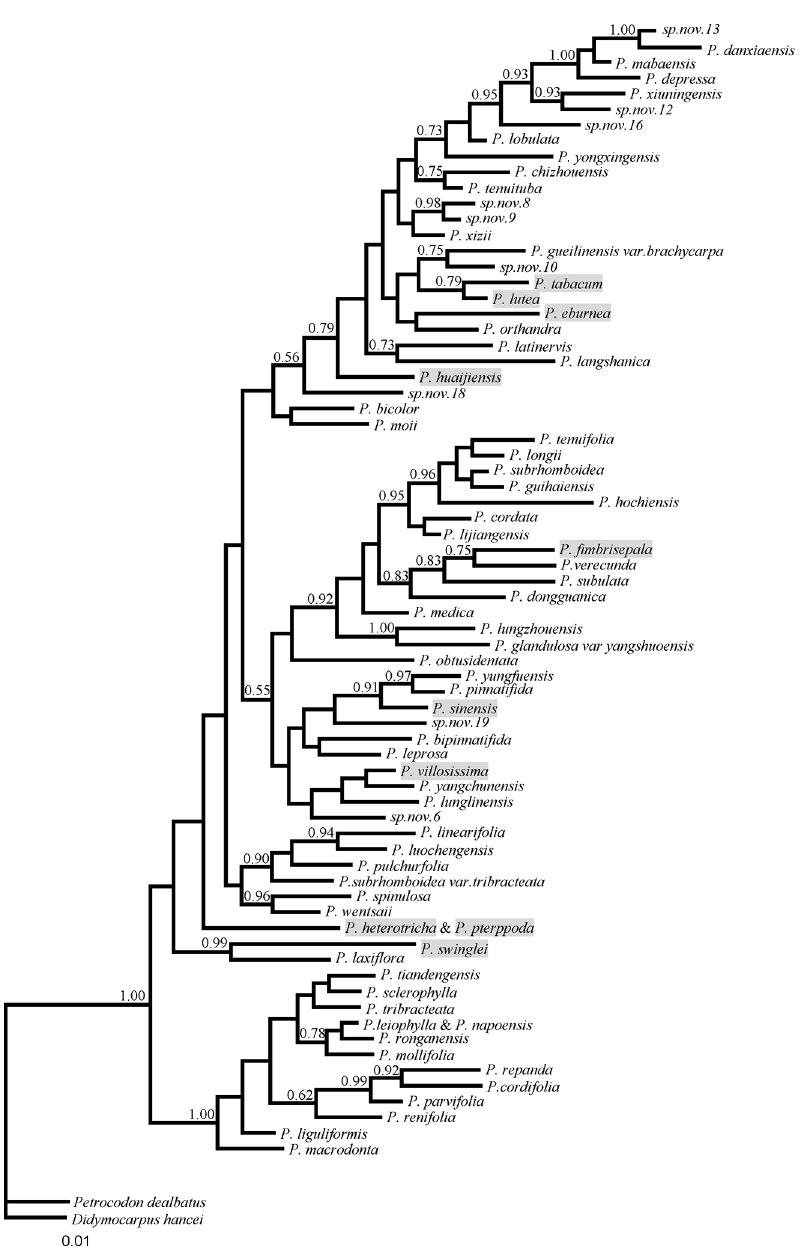
Fig 1. Bayesian phylogenetic tree of partial PHYE sequences for 74 Primulina species. Bayesian posterior probabilities above 0.5 were labeled at the nods. Petrocodon dealbatus and Didymocarpus hancei were used as outgroups. The species with full-length sequences are